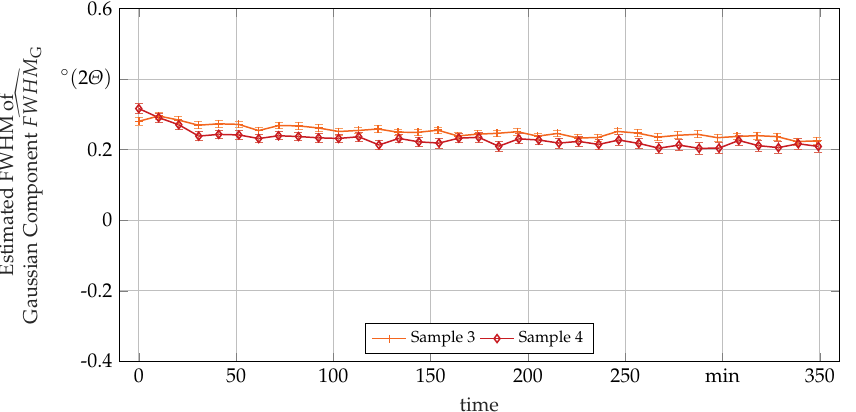
(cid:92) FWHM G of the used Voigt peak shape